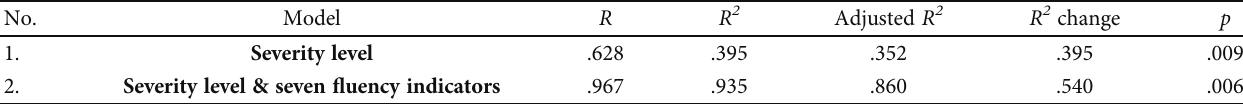
Table 3: Model summary of the multiple regression.